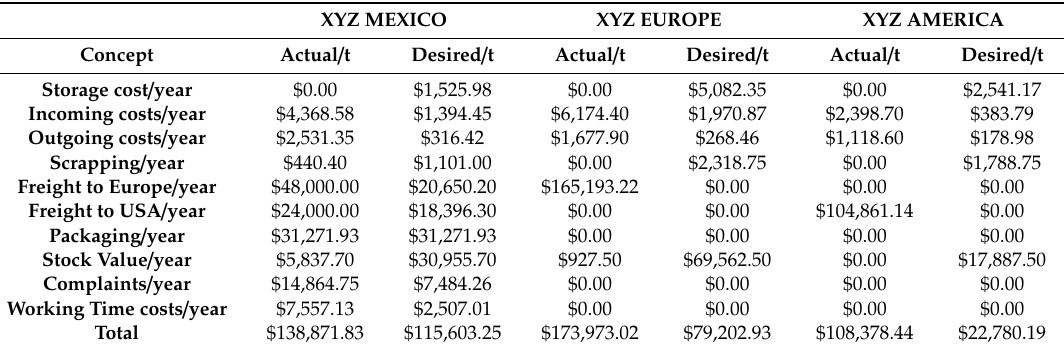
Table 6. Costs for delivery door-side trim panel.